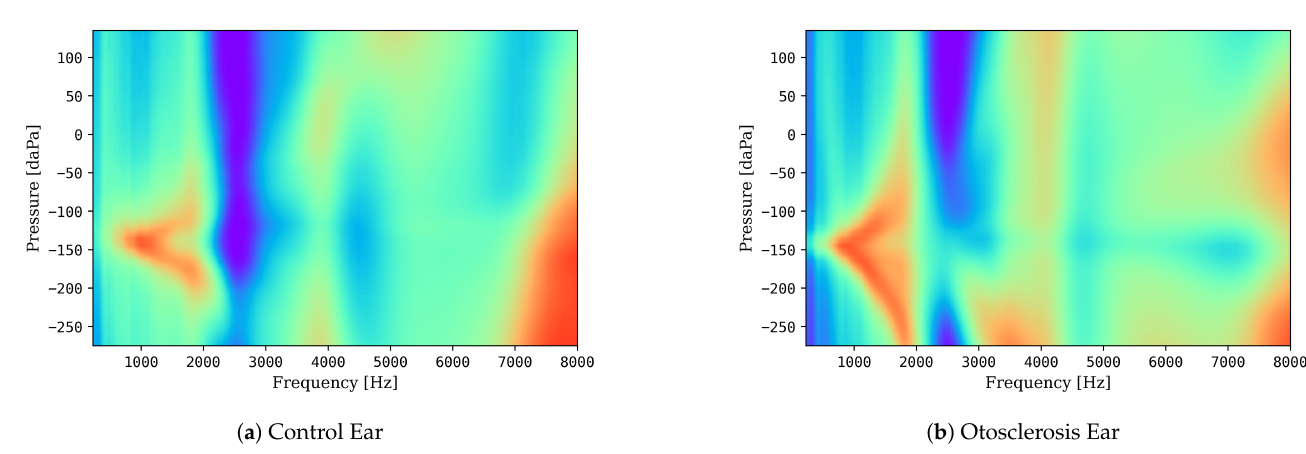
Figure 3. Examples of WBT images in patients with otosclerosis and control subjects; ( a ): the WBT sample in a control subject; ( b ): the WBT sample in a patient. Visually, the WBT image shows a distinct absorbance peak ( − 200–0 daPa, < 2000 Hz) in the control ear, while the peak is flattened in patients with